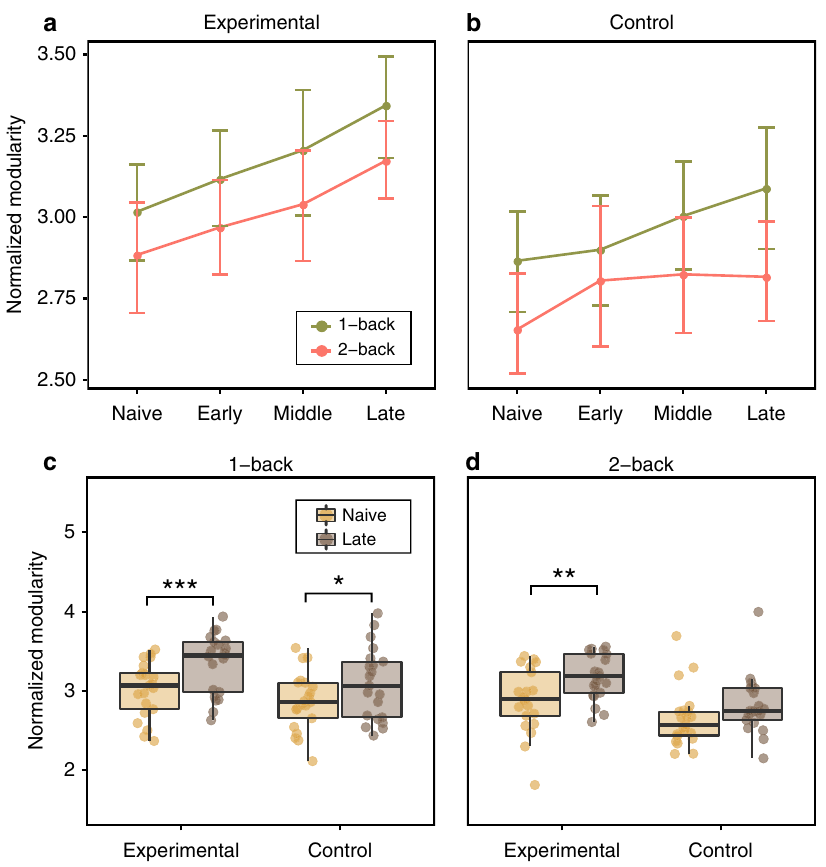
Fig. 4 Modularity differences across the task, sessions, and groups. a , b Line plots representing the mean values of modularity for each scanning session (Naive, Late, Middle, and Late) and condition, separately for a the experimental group ( n = 21) and b the control group ( n = 21). Dots represent mean values; error bars represent 95% con fi dence intervals. c , d Modularity changes from “ Naive ” to “ Late ” sessions for the 1-back condition and the 2-back condition (paired t test, two-sided). We found a signi fi cant increase of modularity in the experimental group c in the 1-back condition ( p = 0.006), and d in the 2-back condition ( p = 0.013). Boxes represent the interquartile range (IR) between 25th and 75th percentiles. The thick line in the center of each box represents the median. The upper and lower error bars display the largest and smallest values within 1.5 times IR above 75th percentile and below 25th percentile, respectively. *** p < 0.01 Bonferroni-corrected; ** p < 0.05 Bonferroni-corrected; * p < 0.05 uncorrected; paired t test; two-sided. Source data are provided as a Source Data fi